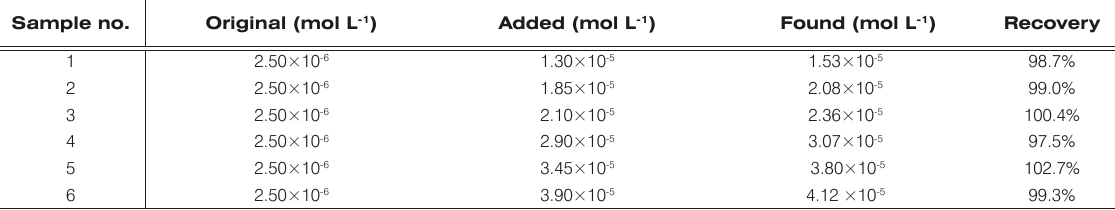
Table 3. The determination results and recovery analysis of p- nitroaniline sample. Sample no.